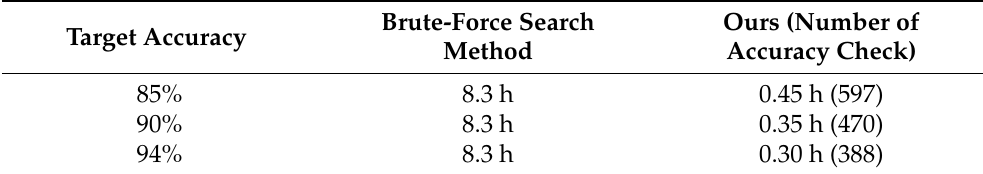
Table 8. The execution times in the corresponding accuracies derived from the proposed method and the individual cases of network slimming and deep compression for ResNet-110.